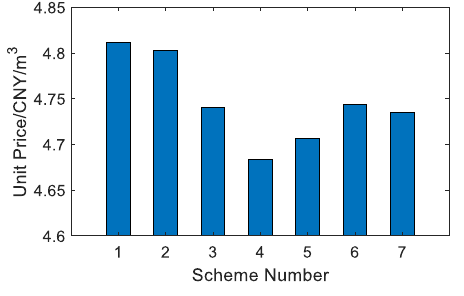
Figure 10. Comparison of unit price.